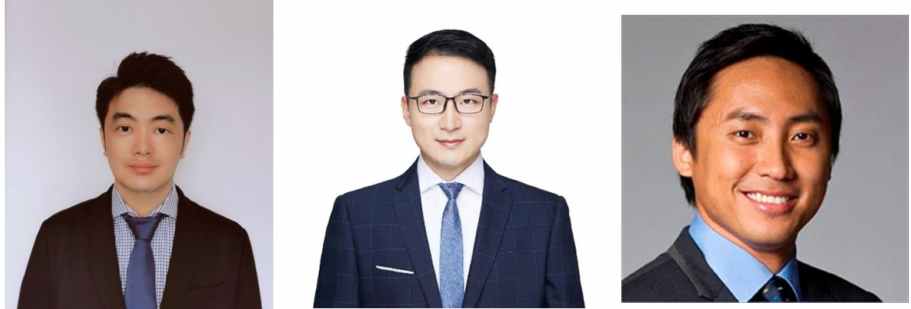
Figure 1. From left to right: Ziwen Liu received his PhD degree from School of Science and Technology at the Singapore Uni-versity of Social Sciences (SUSS). During his PhD, his research focused on leverage on BIM for green building assess-ment and certification process. Yujie Lu is currently a professor at Tongji University, China. With years of experience in intelligent construction and O&M and green buildings, he has led several domestic and international research projects with funding from the National Natural Science Foundation of China and the National Research Foundation of Sin-gapore (NRF). His research findings were endorsed by the International Energy Association (IEA); JTC Corporation, the largest industrial real estate agency in Singapore; California carbon emissions trading market; and the director of the national affairs development agency of Singapore. Lu Chang Peh is an associate professor at the Singapore University of Social Sciences and is currently the Vice Dean at the School of Science and Technology. He is a PhD supervisor and is keen to do research in multidisciplinary studies in the built environment and technology for